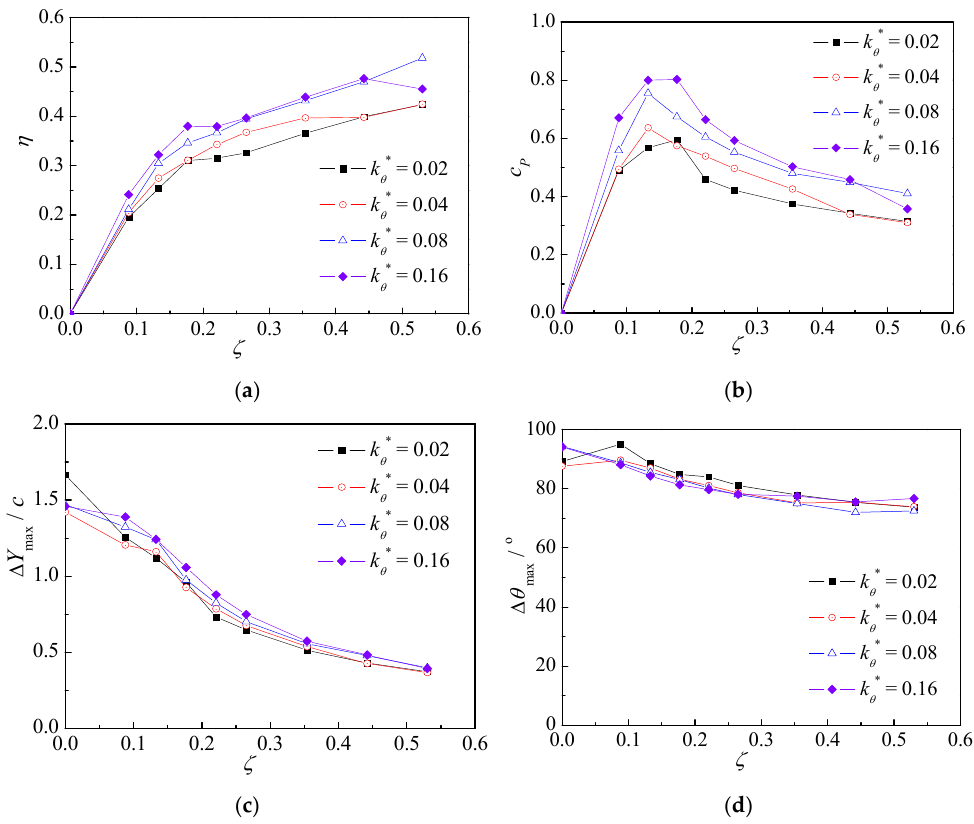
Figure 13. Foil performance parameters as a function of the damping coefficient ζ for various values of pitching spring stiffness coefficient k θ *. ( a ) Efficiency η ; ( b ) power coefficient c p ; ( c ) heave amplitude Δ Y max / c ; ( d ) pitch amplitude Δθ max .